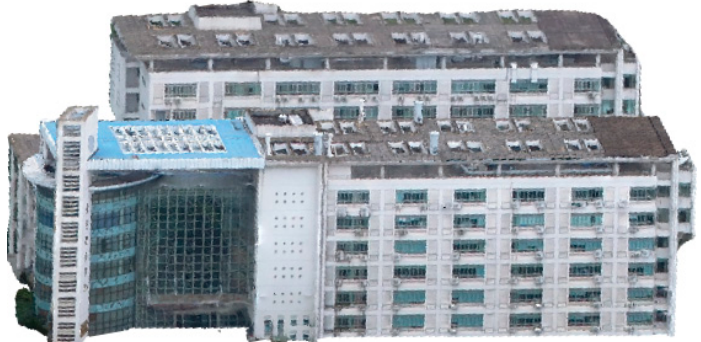
Figure 18. Filled results of building B by the proposed method.